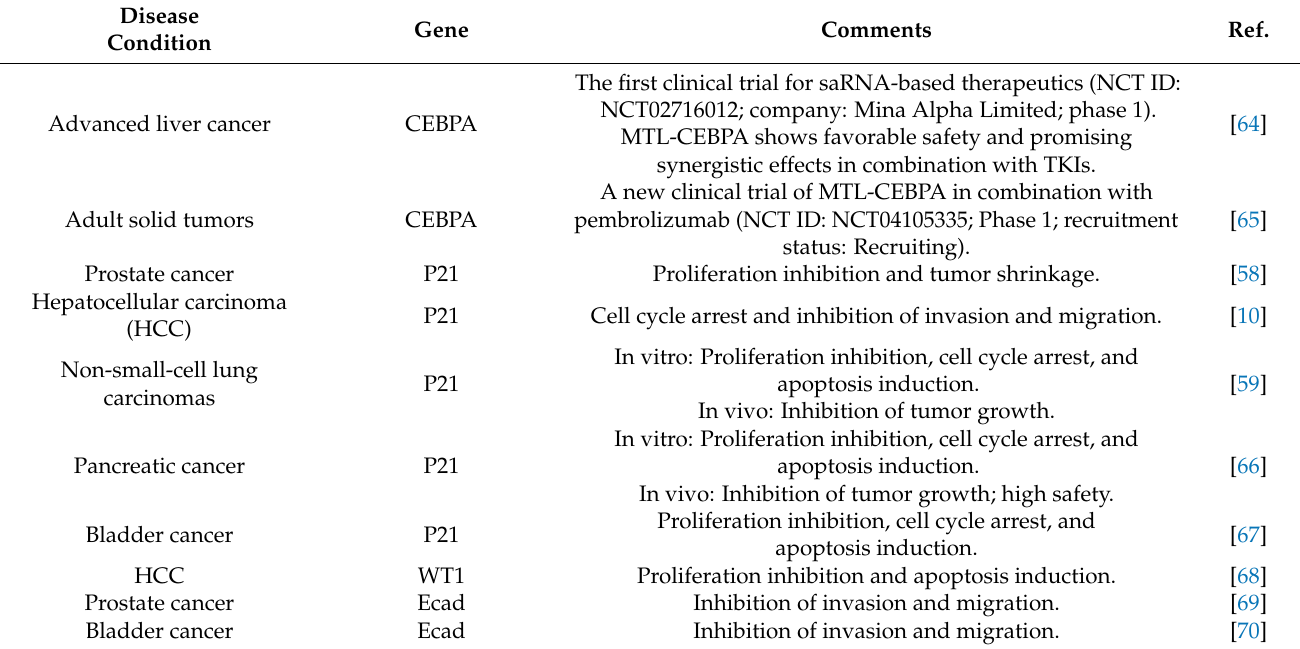
Table 2. Significant preclinical and clinical studies on the features of saRNA-based therapeutics. Disease Comments Gene Condition